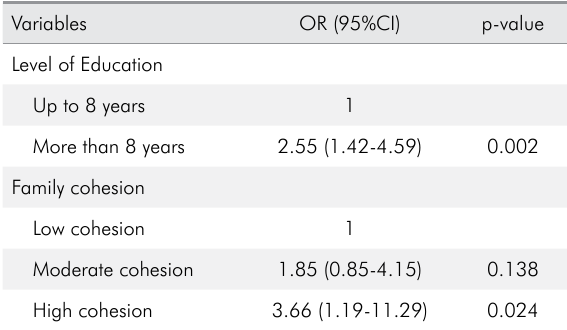
Table 3. Final result of the factors associated with the absence of dental caries experience among 5-year-old